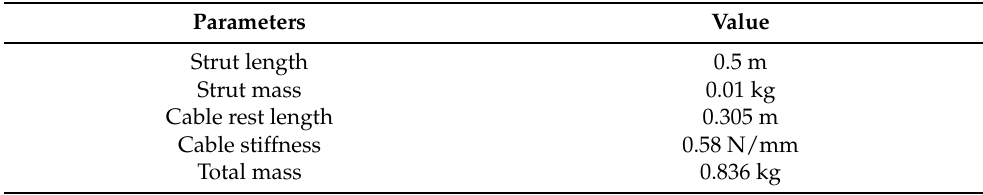
Table 2. Mechanical parameters of the Tensodrone